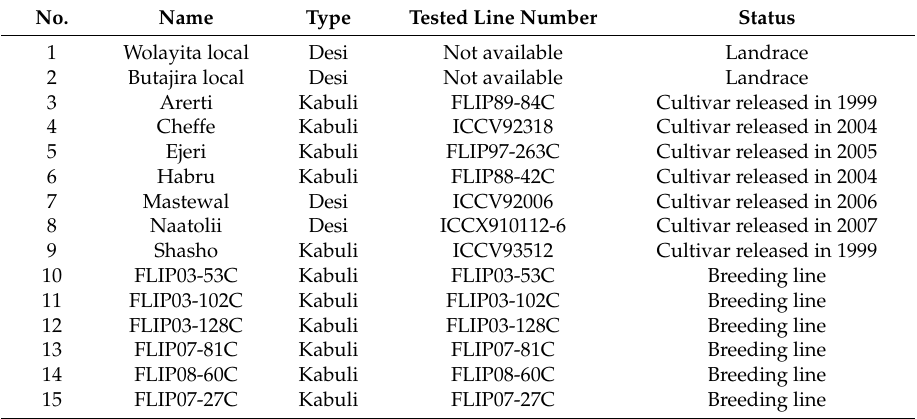
Table 11. Description of chickpea cultivars tested for their response to soil applied zinc fertilizer.